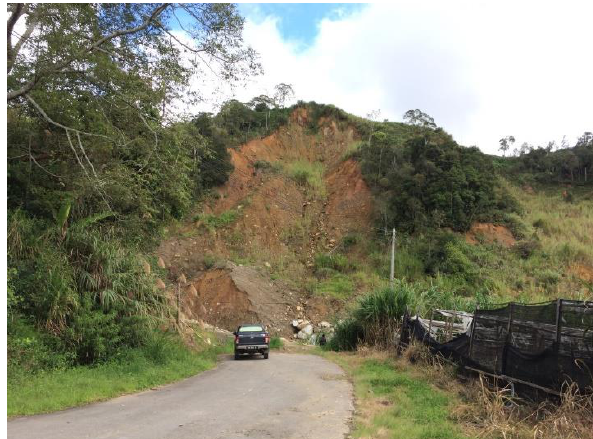
Figure 17. Active rotational landslide on the Mesilau